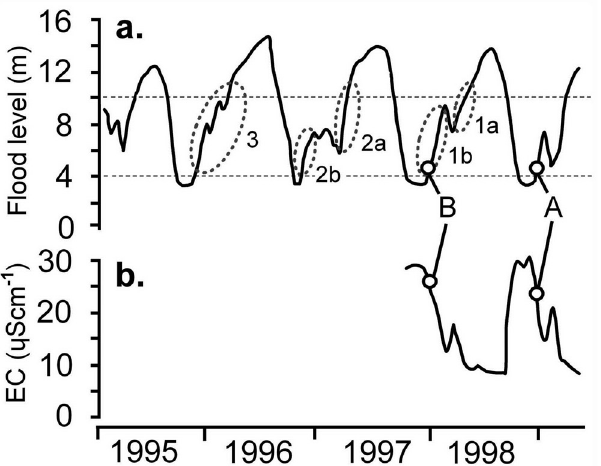
Fig. 2. (a) Flood level and (b) electrical conductivity (EC) monitored in lago Amanã during the period 1995-1998. The timing of sampling in Uxi Bay is marked by A (1998) and B (1997). Dotted horizontal lines mark where shore-scrub (4m) and higher portions of blackwater igapó forest (10m) are inun - dated (Fig. 1). Dotted circles are speculated spawning events for the putative cohort groups 1a through 3 (refer to Fig.